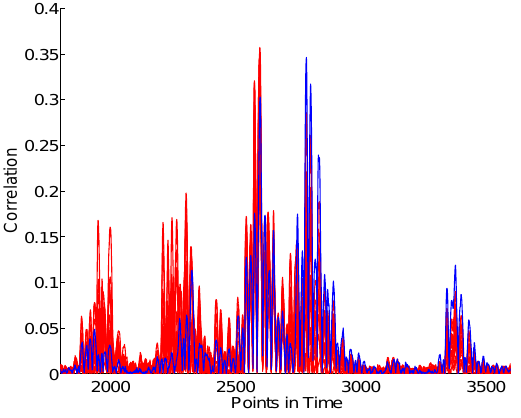
Figure 16: CPA on HO encoding with 100k traces, blue line indicating correct key hypothesis and red lines indicating the wrong key hypotheses